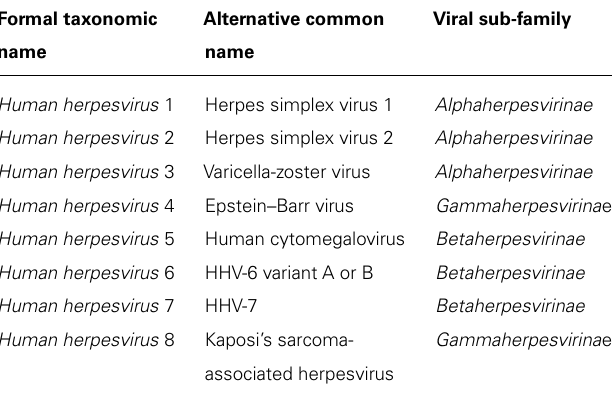
Table 1 | Classification of the eight human